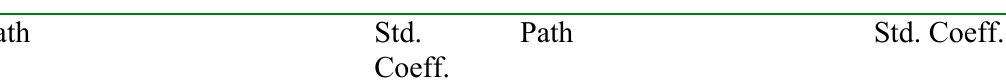
Table 1. Standardized path coefficients from latent to observed variables